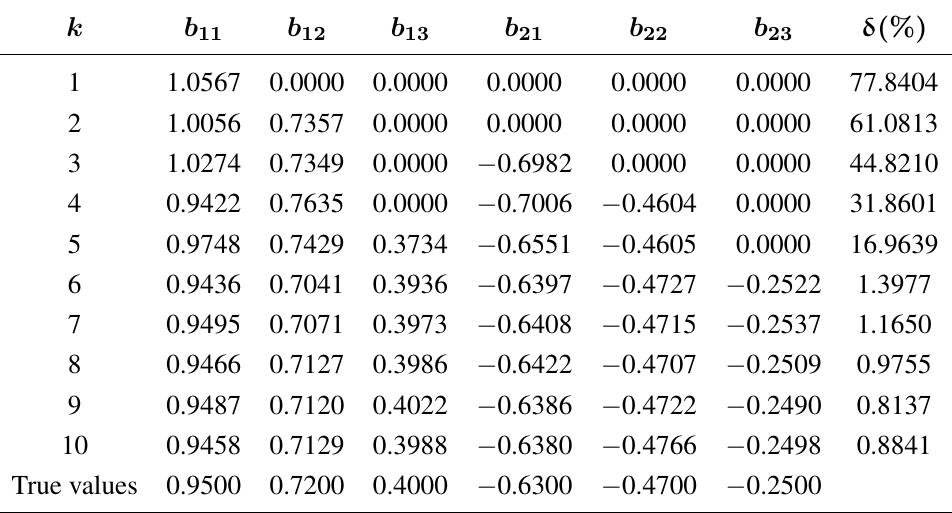
Table 1. The estimation error δ versus iteration k ( m =80, σ 2 = 0 . 10 2